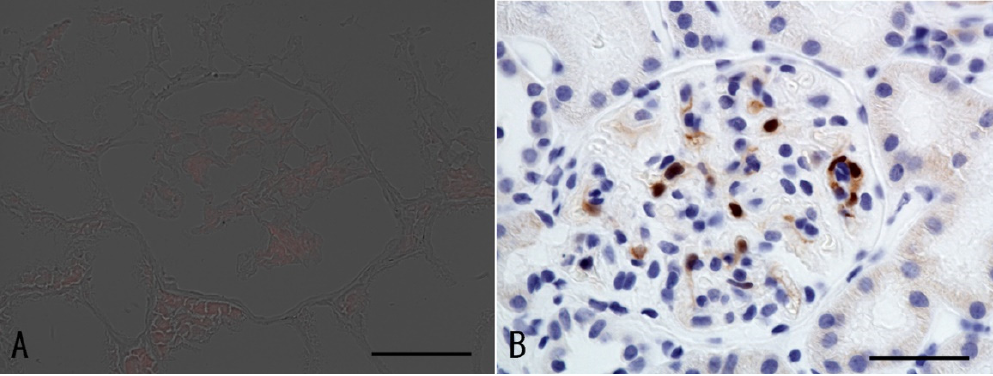
Figure 2. Immunofluorescence of IgG subclass staining. The bars indicate 50 μ m.